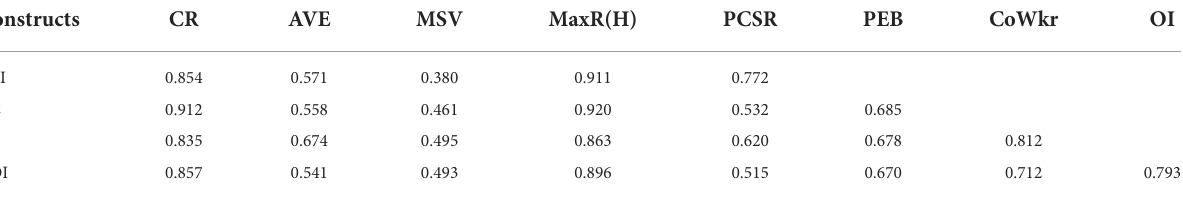
TABLE 4 Discriminant